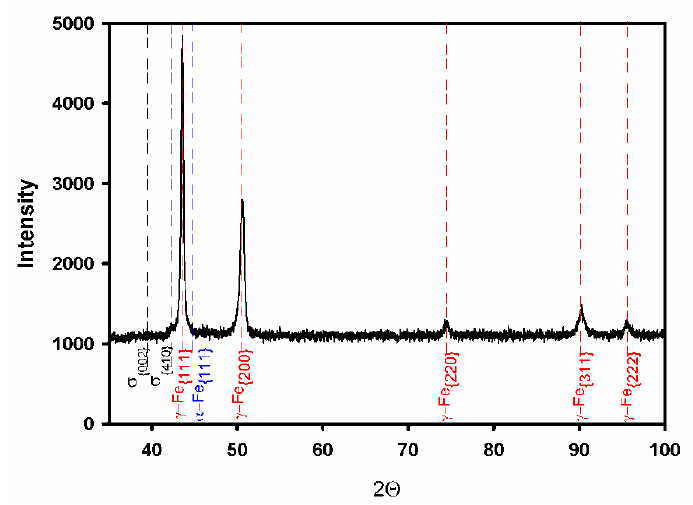
Figure 2. X-ray diffraction pattern of a highly-alloyed austenitic stainless steel annealed at 800 °C.